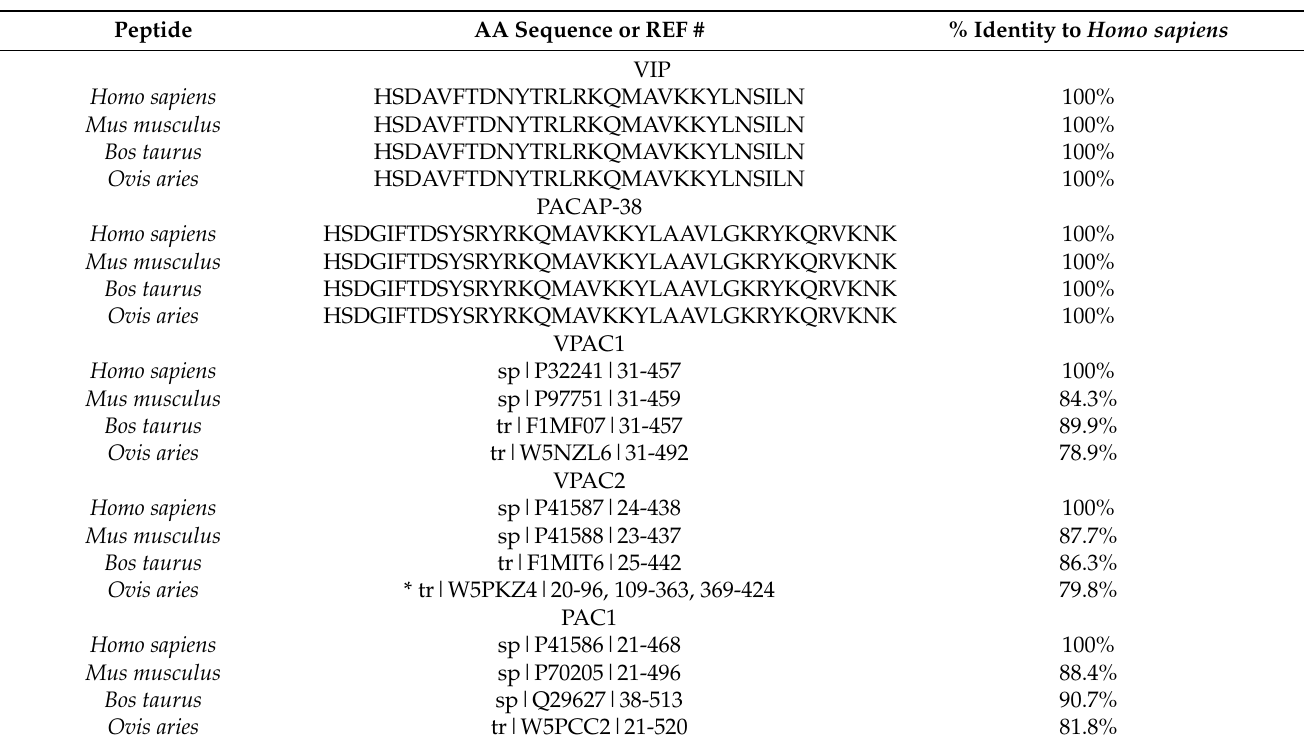
Table 3. Superfamily Member Identities. Species names, amino acid sequence of VIP and PACAP, amino acid lengths of endogenous receptors, and amino acid percent identify as indicated in Homo sapiens, Mus musculus, Ovis aries, Bos taurus . Identity aligned with NCBI multiple